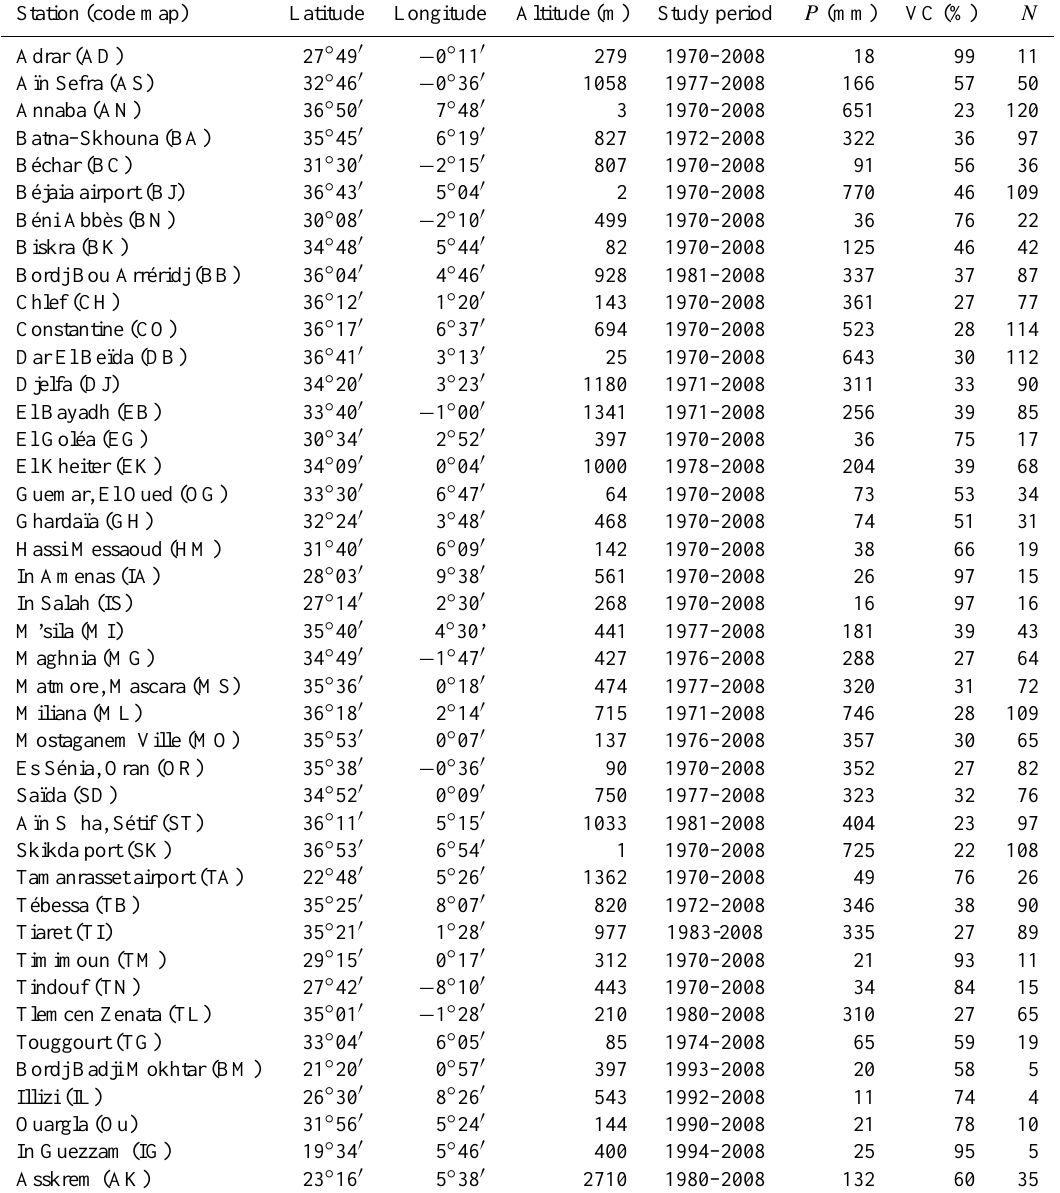
Table 2. Geographic coordinates and average annual rainfall ( P ), variation coefficient (VC) and average number of rainy days ( N ) for 42 meteorological stations across Algeria (during the period from 1970 to